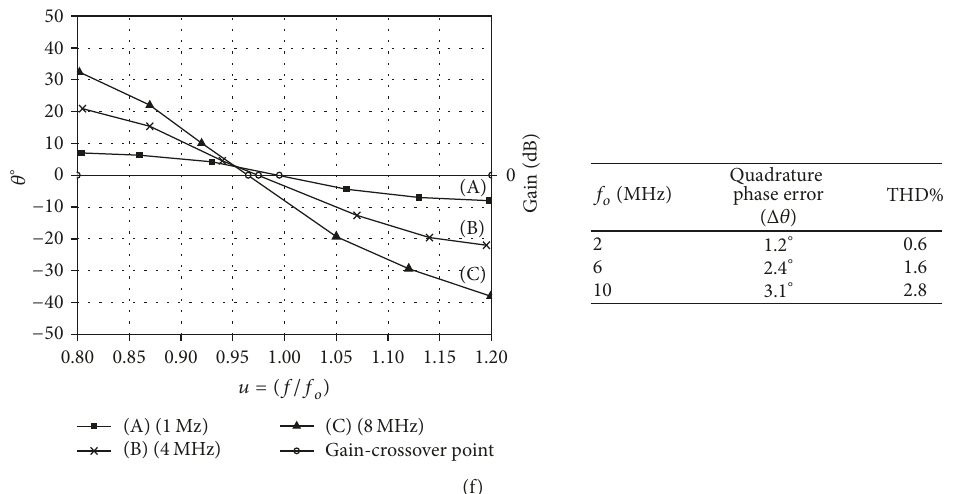
Figure 3: Measured response of ETAF and QO. (a) AP phase response: (A) = 9 V.d.c.; (B) = 6V.d.c. (b) AP-THD (%) to 7th harmonic. (c) QO wave response tuned at 10MHz quadrature signals at 𝑉 𝑜 and 𝐸 𝑜 nodes. (d) QO spectral response of 10MHz for phase-noise evaluation. (e) QO linear-tuning response. (f) Measured tuning error of